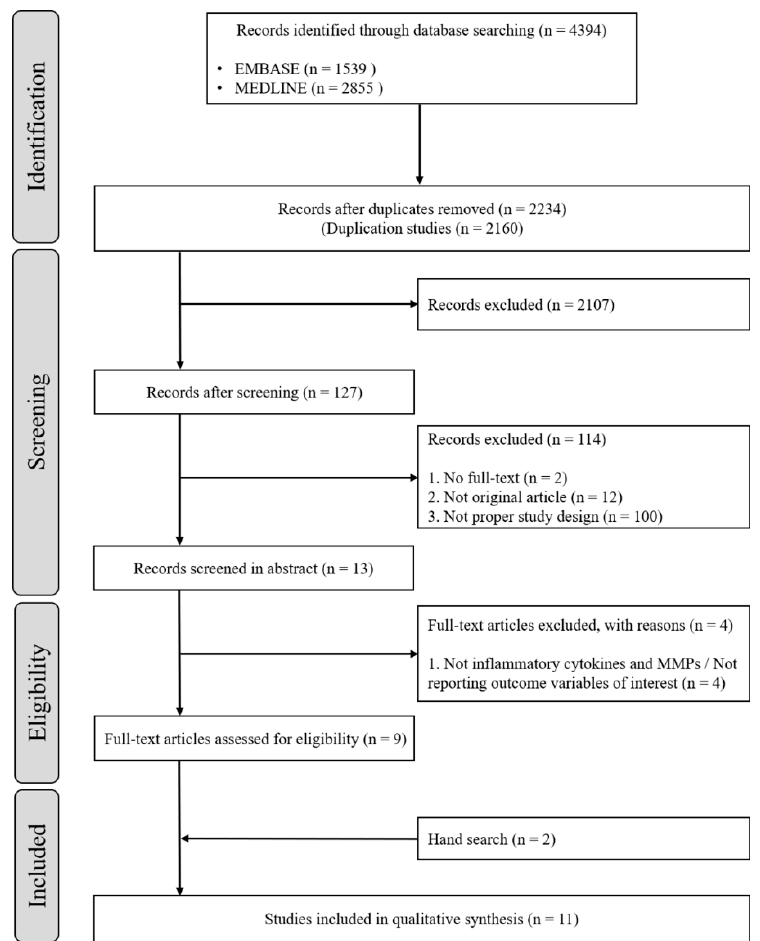
Figure 1. Flow diagram of the study selection process.